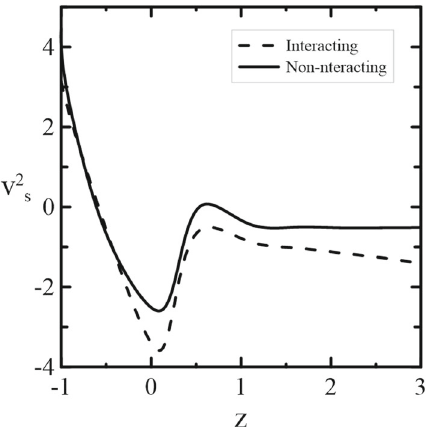
Fig. 8 The matter power spectrum of interacting and non-interacting THDE models with consideration of the Hubble horizon as IR cutoff compared to the (cid:2) CDM according to the best fitted values listed in Table 1. Both interacting and non-interacting THDE models show a considerable suppressing of matter power spectrum at large scale or small k